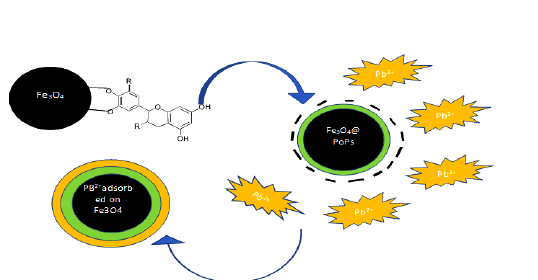
Figure 11. Proposed mechanism of lead (II) removal by using Fe 3 O 4 NPs as adsorbent